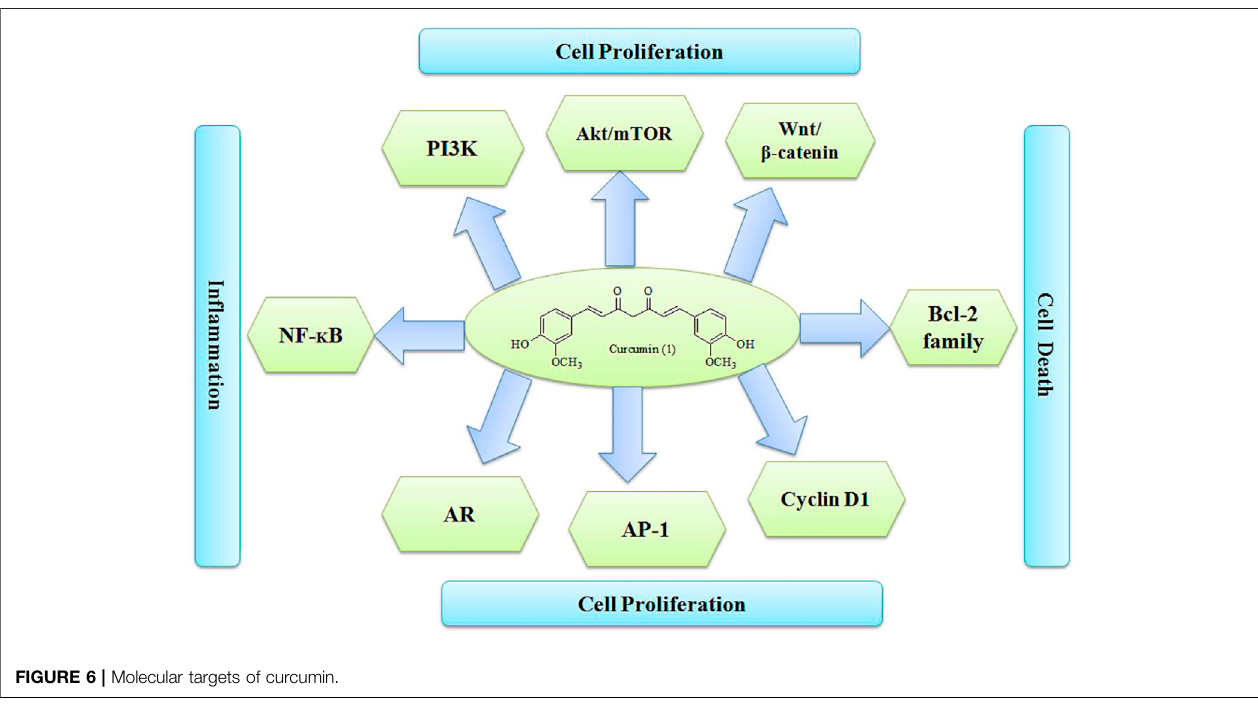
FIGURE 6 | Molecular targets of curcumin.